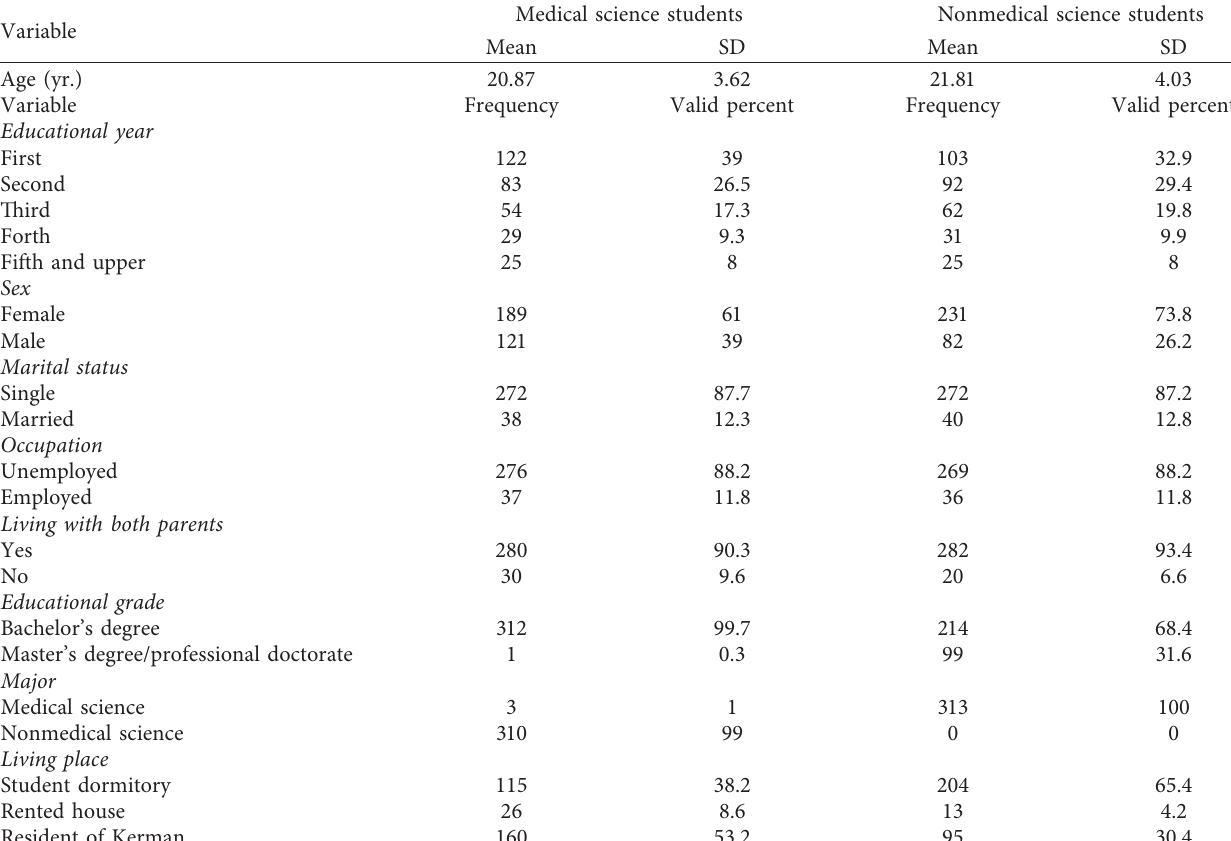
Table 1: Sociodemographic characteristics of the sample ( n � 626).